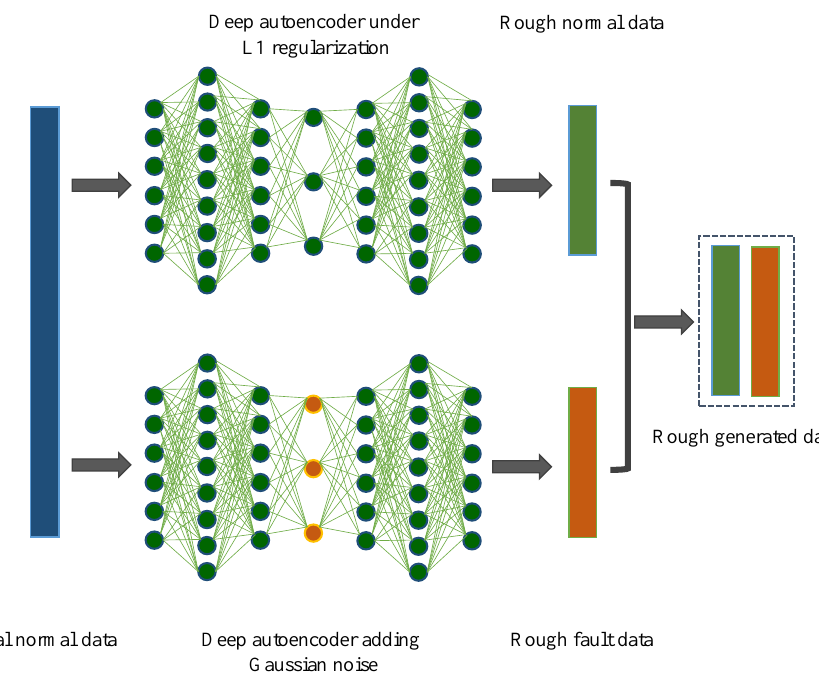
Figure 6. The process of generating rough